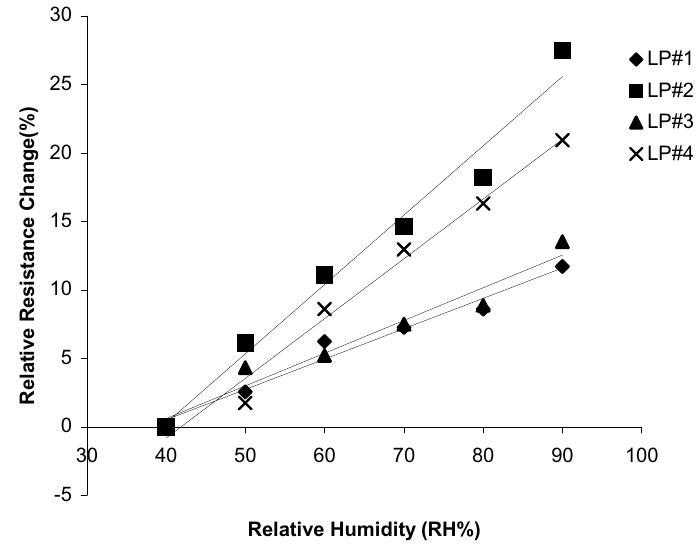
Figure 11. Humidity Sensitivity Curves for In